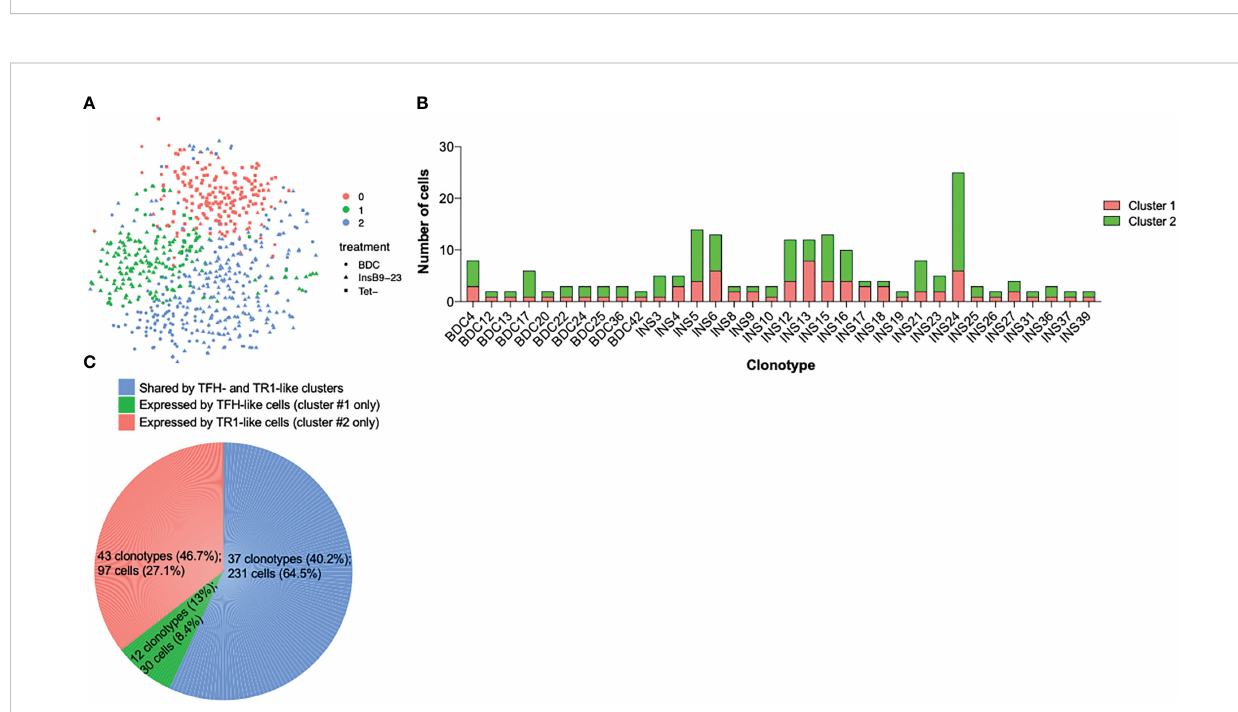
FIGURE 4 Clonotypic diversity of the tetramer+ vs tetramer- CD4+ T-cells arising in pMHCII-NP-treated mice. (A) Distribution of clonal sizes and TCR speci fi city. Data correspond to number of cells expressing each of the 45 different TCR ab pairs that were found in more than one cell, or the ~300 that were found only once (labeled as “ unique ” in the plot). (B) Average length in amino acids (± SEM) of the CDR3 a or CDR3 b sequences of the TCRs expressed by the tetramer+ cells arising in response to treatment with the three different pMHCII-based nanomedicines. (C) Schematic representation of the percentage of prevalent amino acids at speci fi c positions at the N terminus of CDR3 sequences ( fi rst 6 residues) for each pMHCII speci fi city normalized against the frequency of each residue at each position. Numbering of the CDR3 residues follows the nomenclature of Gioia et al., 2019 (12).